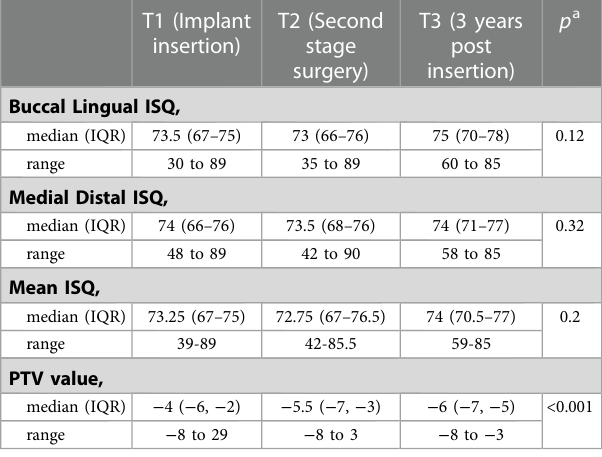
TABLE 2 Spearman ’ s rank correlations for the various osstell ® and periotest ® measurements at each timepoint, n =58. T1 (Implant insertion)